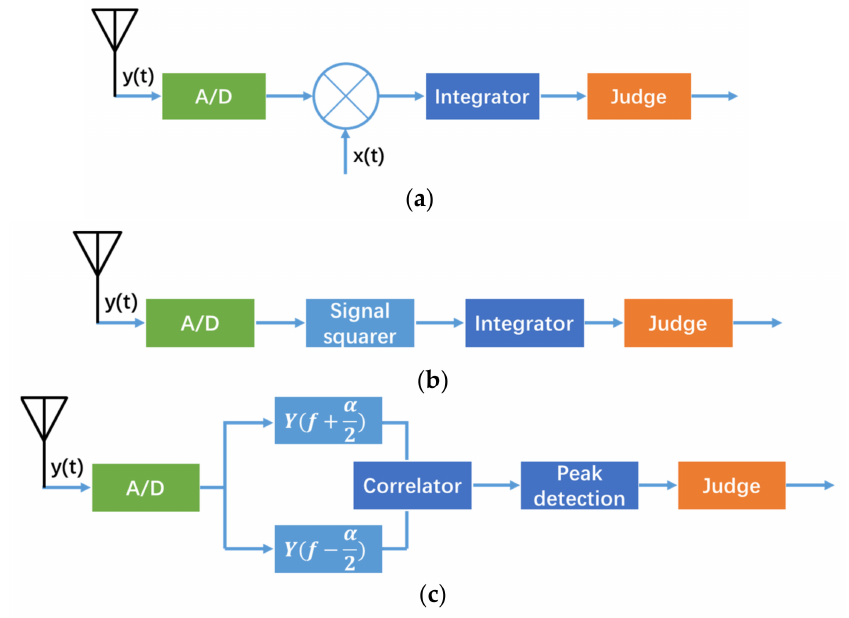
Figure 1. Schematic flow charts of three common detection methods. ( a ) Schematic flow chart of coherent detection; ( b ) schematic flow chart of energy detection; ( c ) schematic flow chart of cyclostationary feature detection.